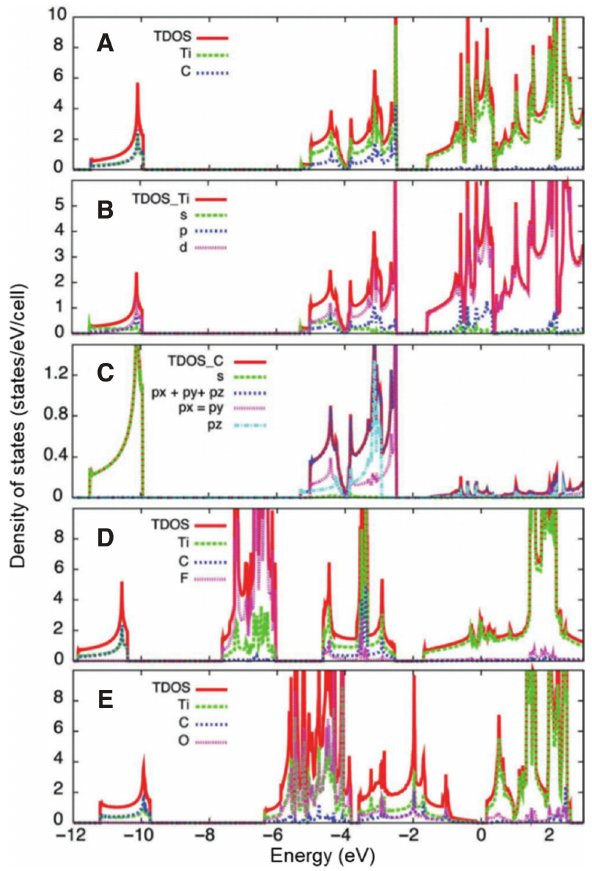
C, Ti and C atoms, Ti CF , 2 2 2 CF and Ti CO , respectively. 2 2 2 2